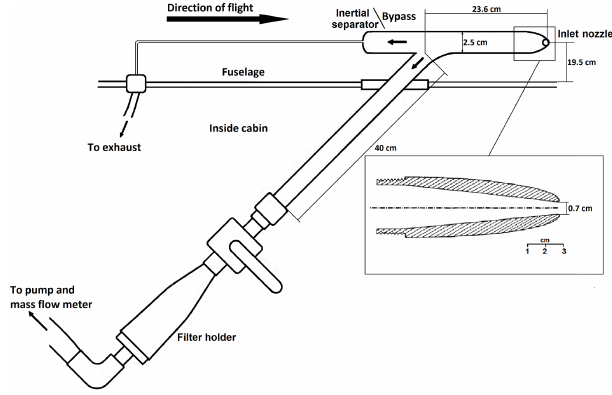
Figure 1. Schematic diagram of one of the two parallel lines of the filter inlet system.